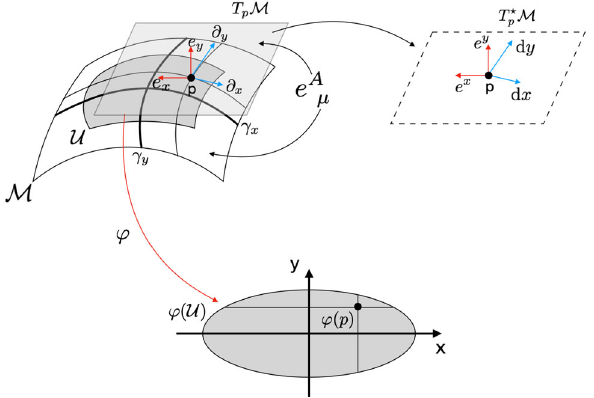
Fig. 4 Two-dimensional picture to explain the tetrad formalism. Tetrads e A μ solder the coordinate chart ( U ,ϕ) on the manifold M to (cid:4) (cid:5) e x , e y the orthonormal basis in the tangent bundle T p M . They repre- (cid:5) (cid:4) ,∂ ∂ . The sent also the coefficients in the natural (holonomic) basis x y coordinate map ϕ assign at each point p ∈ U ⊆ M the coordinates ϕ( p ) = ( x , y ) ∈ ϕ( U ) ⊆ R 4 . Passing from T M to the cotangent p bundle T (cid:13) p M through g μν and η AB , the natural basis { d x , d y } is trans- formed into the orthonormal basis { e x , e y } through the use of tetrads μ e